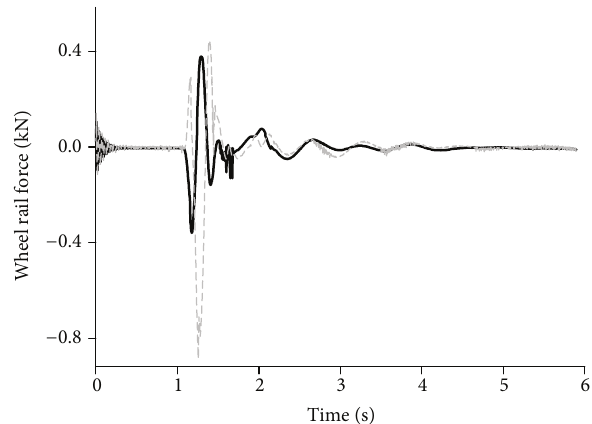
Figure 11: Vertical wheel/rail force corresponding to elastic two- block sleeper continuously voided. Bold line: one sleeper voided; solid line: two sleepers continuously voided; dashed line: three sleepers continuously